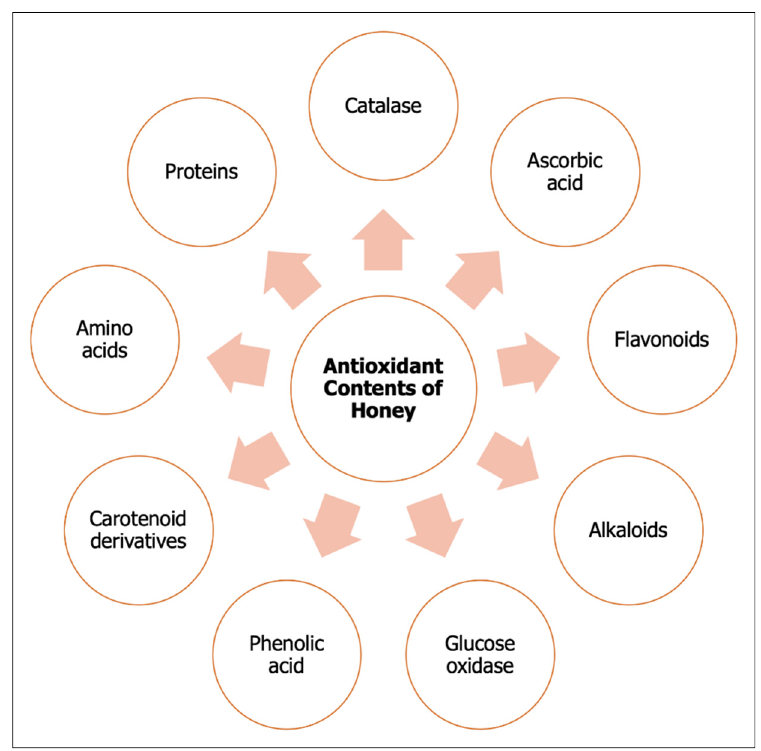
Figure 1. Antioxidant contents of honey.